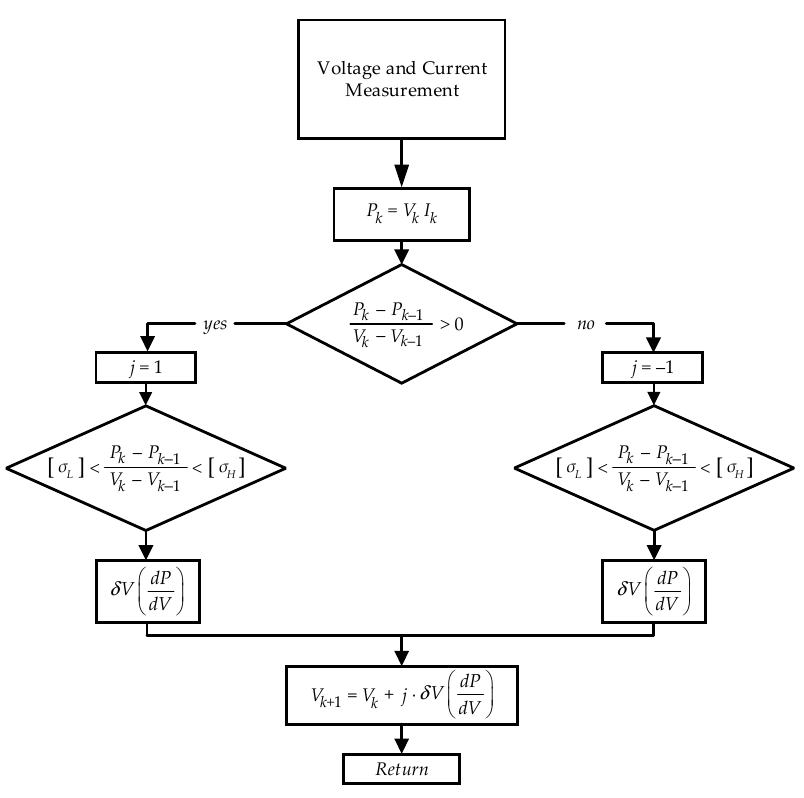
Figure 4. Maximum power point tracking (MPPT) flowchart.